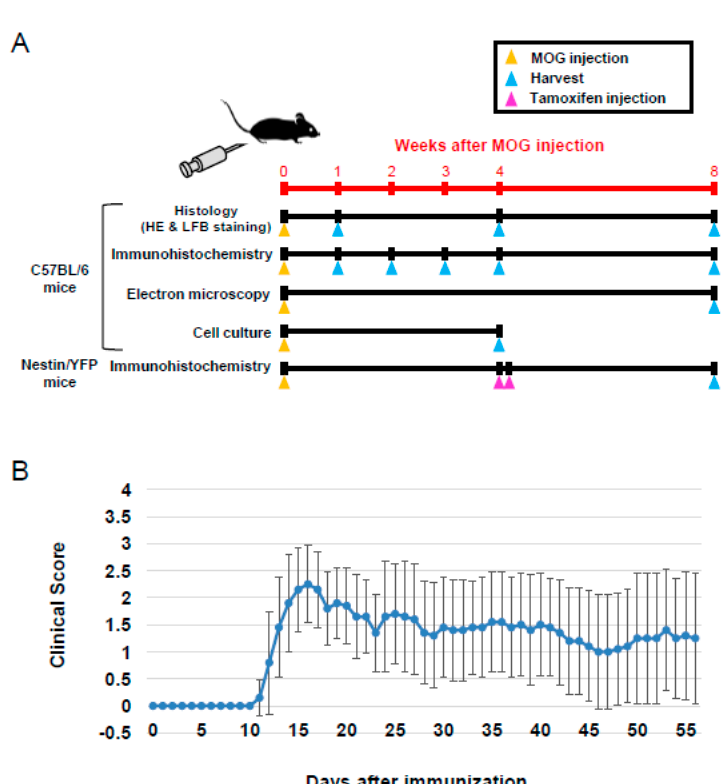
Figure 1. Schematic representation of timing for MOG immunization and tamoxifen injection. Harvested lumbar spinal cords were subjected to histology, immunohistochemistry, EM, and cell culture ( A ). C57BL/6 mice were immunized with MOG, and clinical scores were assessed daily. Results are shown as mean + SD ( N = 10) ( B ). Abbreviations: MOG, myelin oligodendrocyte glycoprotein; EM, electron microscopy.